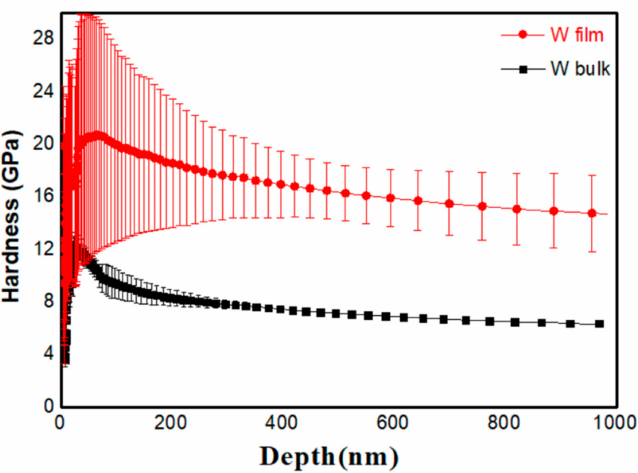
Figure 2. Hardness displacement curves for pure W bulk and W film before exposure.